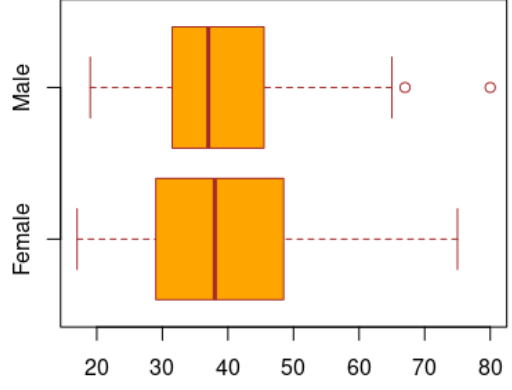
Figure 2. Age distribution in females and male patients. Table 1. Reported symptoms persistence in days.